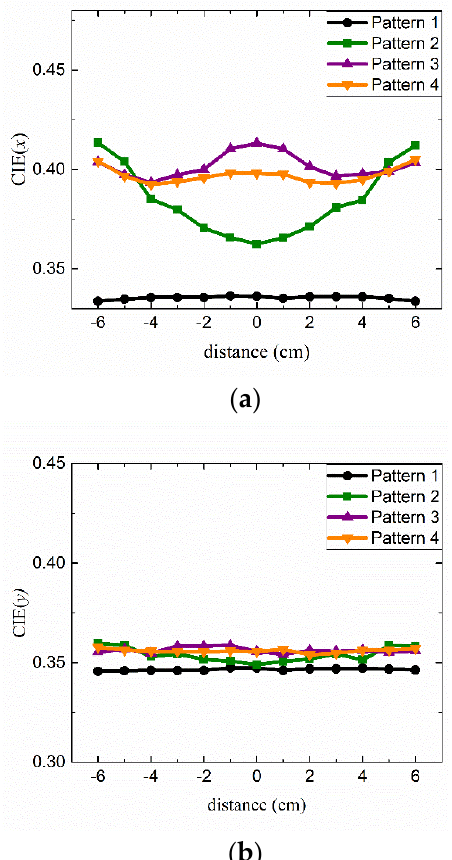
Figure 7. The positional dependence of the color coordinates ( a ) x and ( b ) y along the horizontal direction was measured for all four patterns shown in Figure 4.